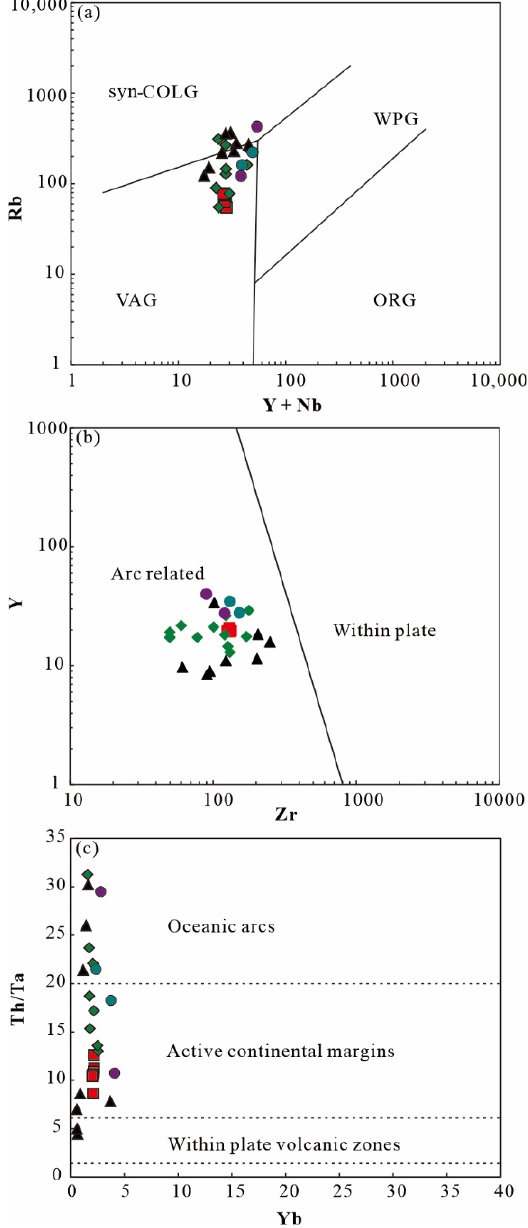
Figure 10. ( a ) Rb vs. Y + Nb [69]; ( b ) Y vs. Zr; ( c ) Th/Ta vs. Y [70]. Data are from the same source as Figure 5.